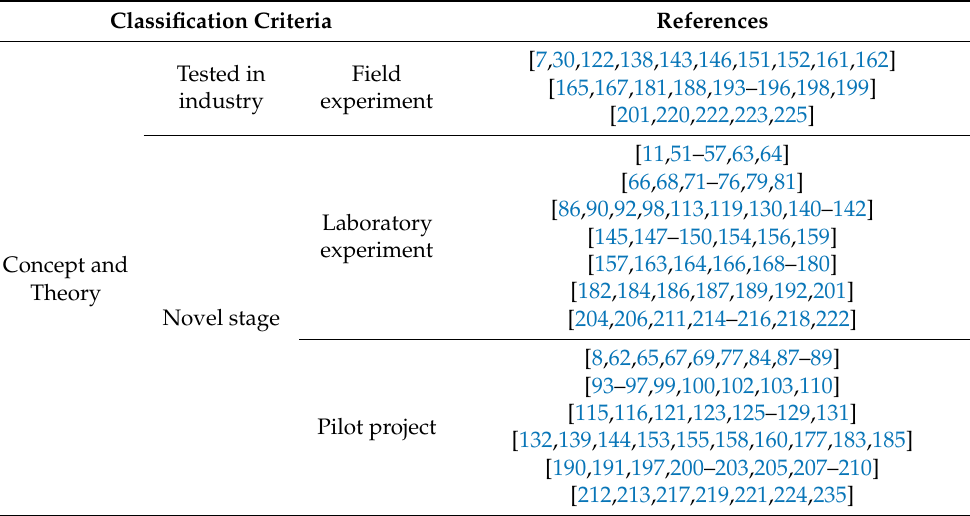
Table 10. Layer 4 AR solutions and their industry adoption status 2010–2021. Classification Criteria